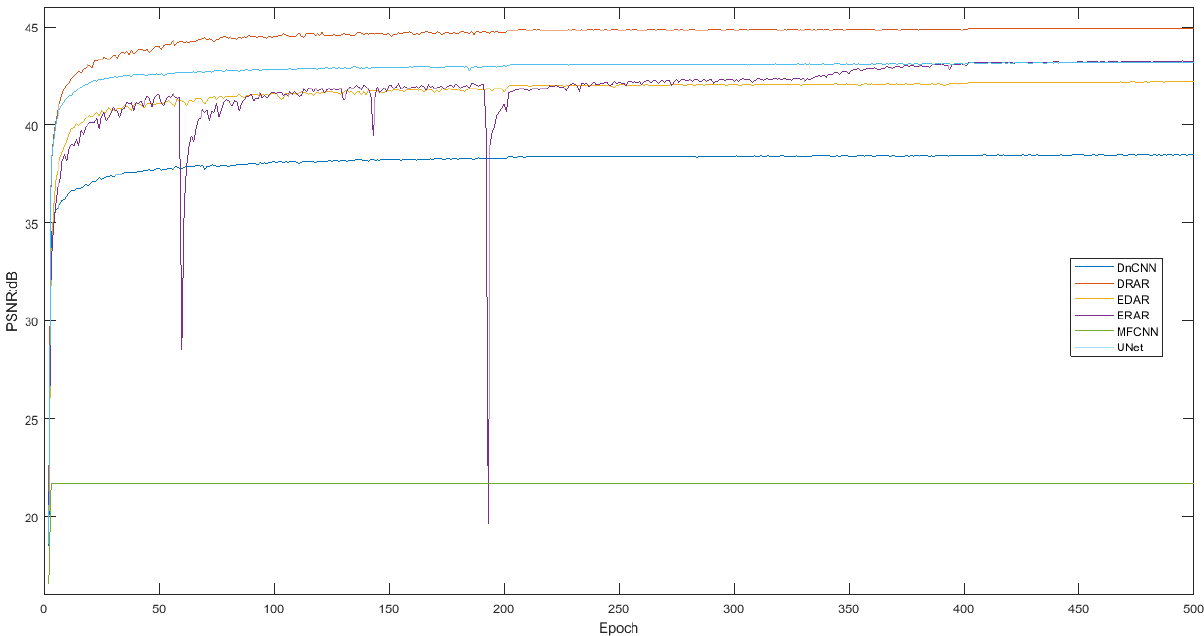
Figure 14. PSNR of DnCNN, ERAR, MFCNN, UNet, EDAR, and DRAR during training